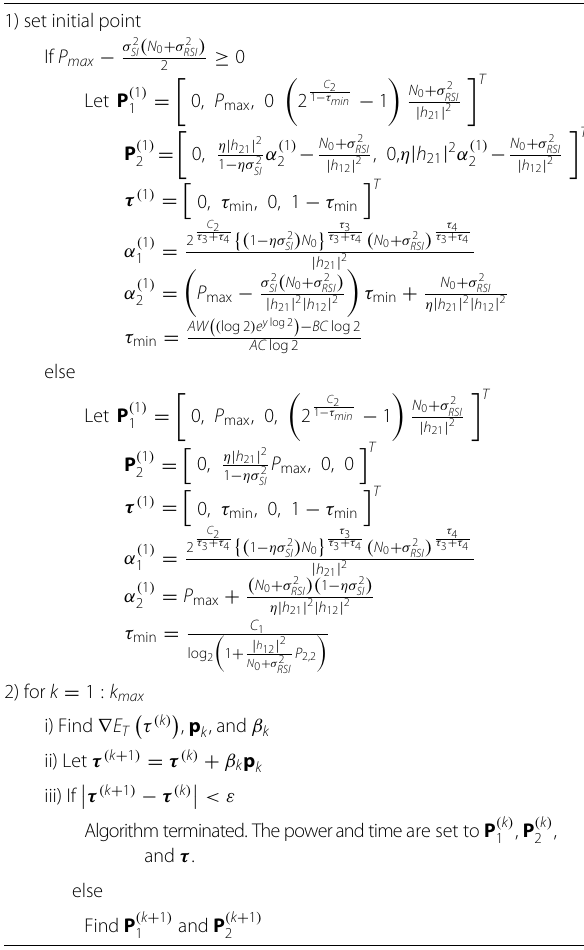
Table 1 Algorithm of the proposed iterative scheme for the optimization of the proposed